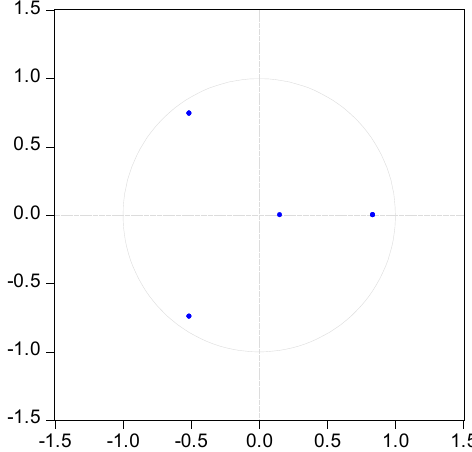
Figure 3. Inverse roots of AR characteristic polynomial.